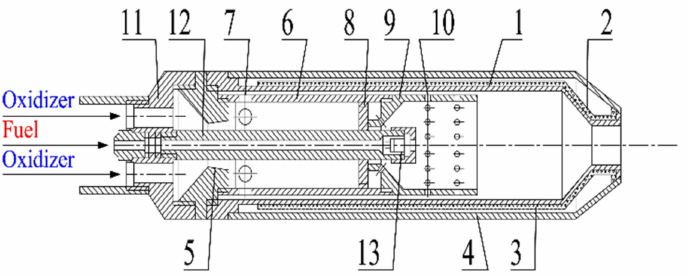
Figure 4. Unified burner, equipped with capillary-porous cooling structure (coating) and high- pressure vortex chamber with supersonic annular nozzle: 1—combustion chamber; 2—nozzle device; 3—capillary-porous coating; 4—casing; 5—nozzle; 6—vortex chamber; 7—outlet openings for cold flow removal; 8—outlet openings for hot flow removal; 9—fore-chamber; 10—oxidant supply open- ings; 11—main channel; 12—fuel supply pipe;